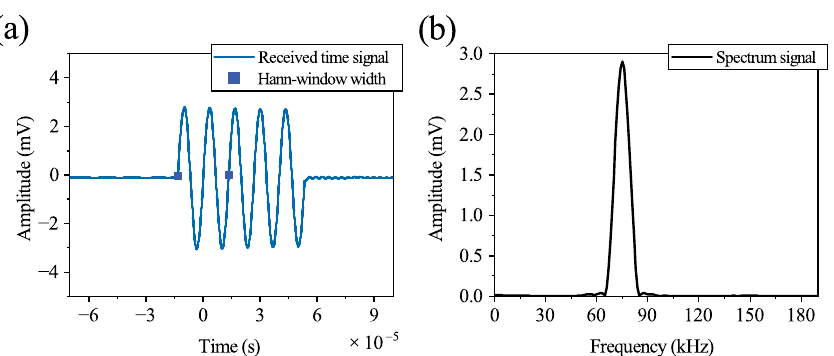
Figure 6. Received signal and spectrum signal for the test in the air: ( a ) time-domain signal ( b ) spec- trum